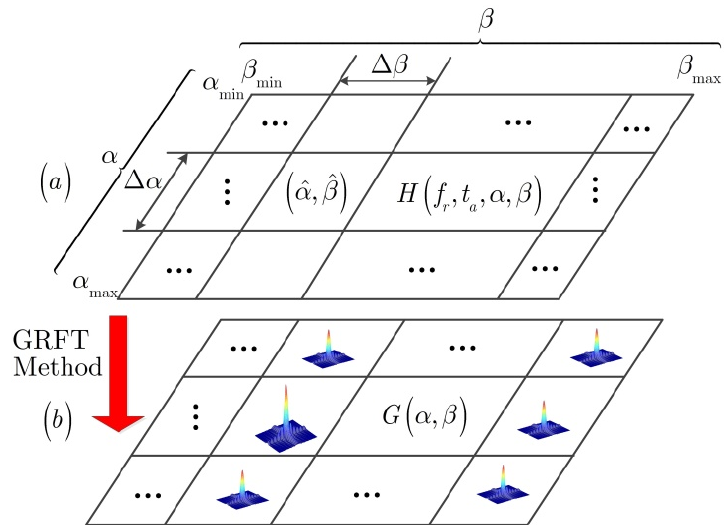
Figure 2. Principle schematic GRFT .